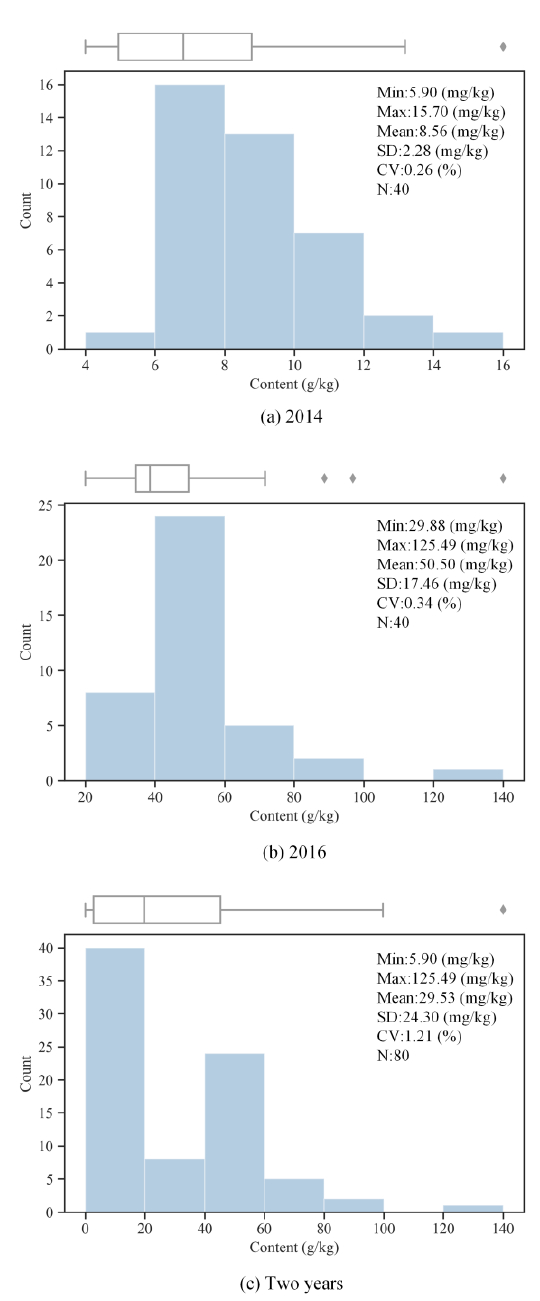
Figure 1. Box-plots and histograms of the Cr content. (a) The content of Cr in 2014. (b) The content of Cr in 2016. (c) The content of Cr in two years. Min: minimum, Max: maximum, SD: standard deviation, CV: coefficient of variation. sample, ten spectral measurement measurements were taken, removed the anomaly spectra and averaged to present the spectral characteristic of the sample. Because of low SNR near 350 nm and 2500 nm, only the 400-2400 nm wavelength range Savitzky–Golay smoothing